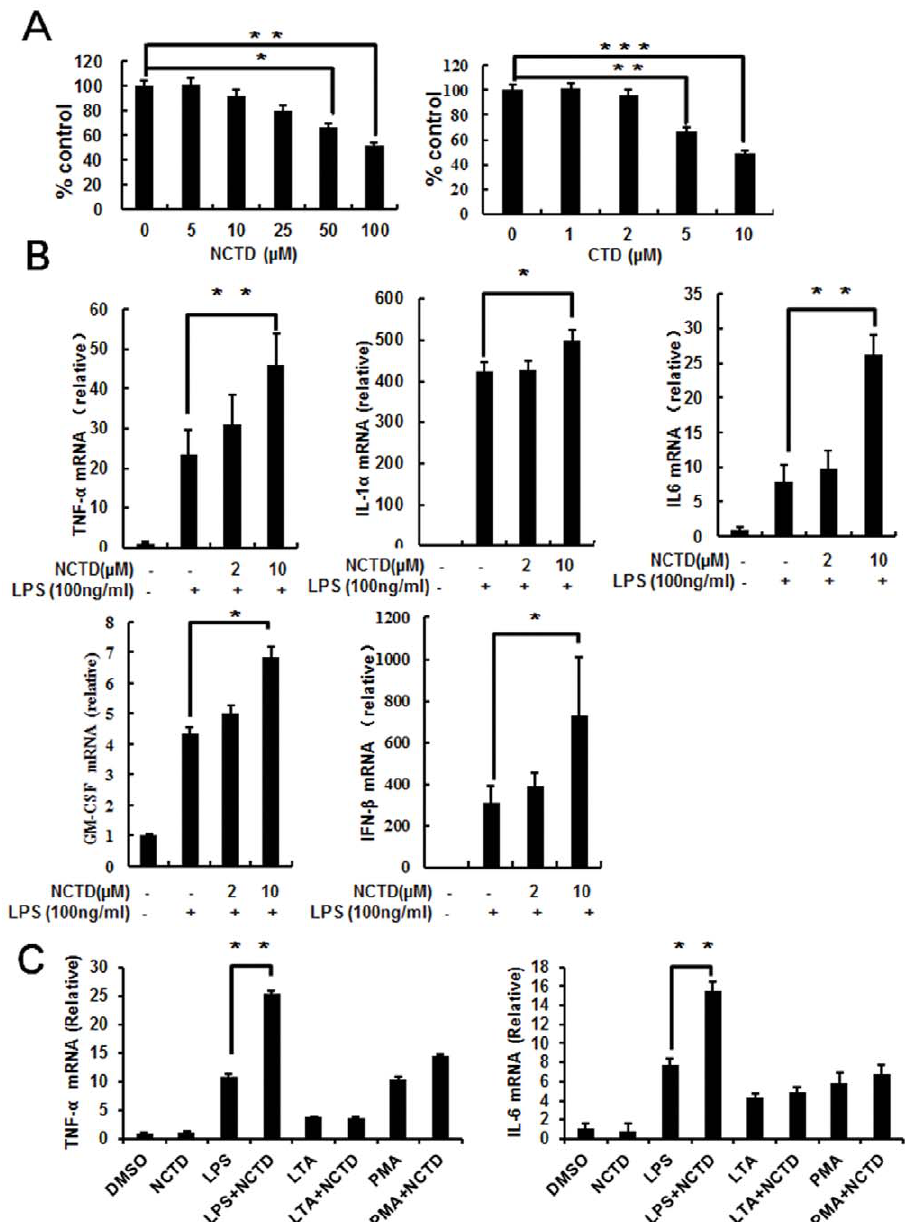
Figure 2. NCTD enhances LPS induced cytokines expression at mRNA level. A, The cytotoxicity of NCTD is much lower than CTD. RAW264.7 cells were treated with NCTD or CTD for 24 h and cell viability was tested with MTS assay as described under Materials and Methods. B, Cytokines production was enhanced obviously by NCTD in RAW264.7 cells. The RAW264.7 cells were pretreated with PBS (containing 0.1% DMSO) or 1–10 m M NCTD for 24 h before stimulation with 100 ng/ml LPS for 1 h. Total cellular RNA were collected and subjected to Real time -PCR analysis. C, Only LPS induced cytokine production was enhance by NCTD obviously. The RAW264.7 cells were pretreated with 0.1% DMSO, 5 m M NCTD for 24 h before stimulation with LPS (100 ng/ml), PMA (100nM) or LTA (10 m g/ml) for 1 h. Total cellular RNA were collected and subjected to Real time PCR analysis. Columns, mean from three independent experiments with three duplicates; bars, SE (*, P , 0.05; **, P , 0.01 versus control).